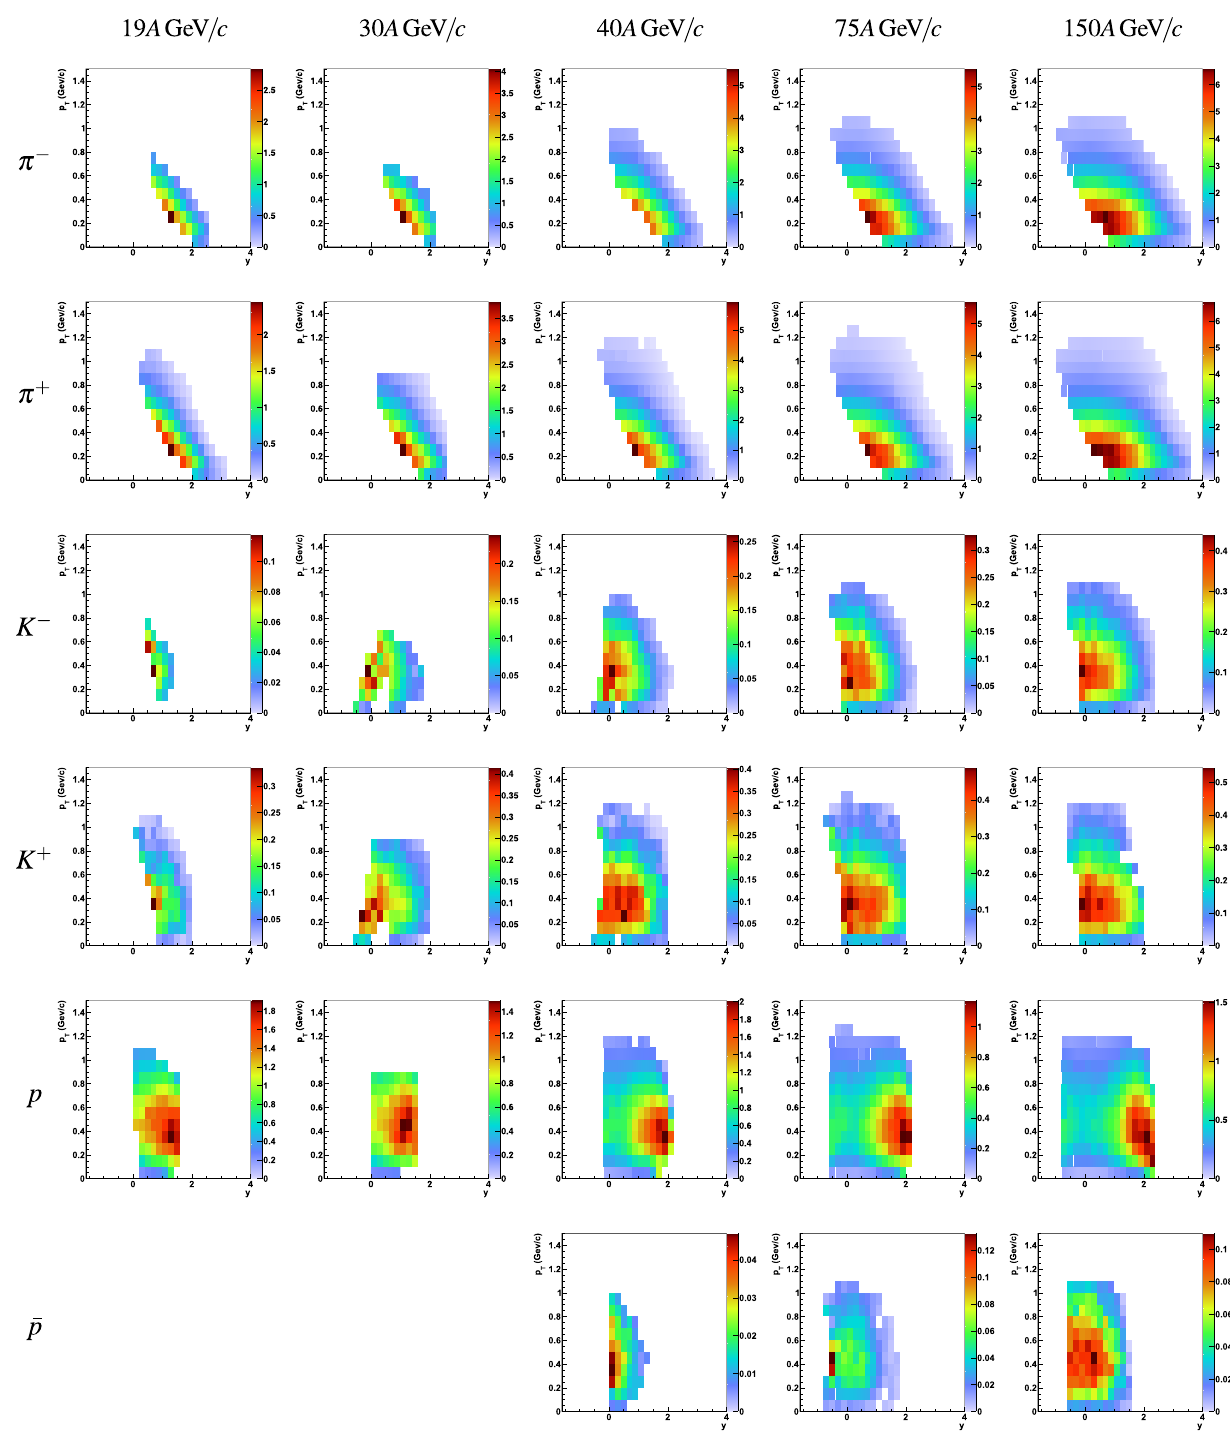
Fig. 15 Two-dimensional distributions ( y vs. p T ) of yields of π − , π + , K − , K + , p and ¯ p produced in the 20% most central Be+Be interactions at 19 A , 30 A , 40 A , 75 A and 150 A GeV /